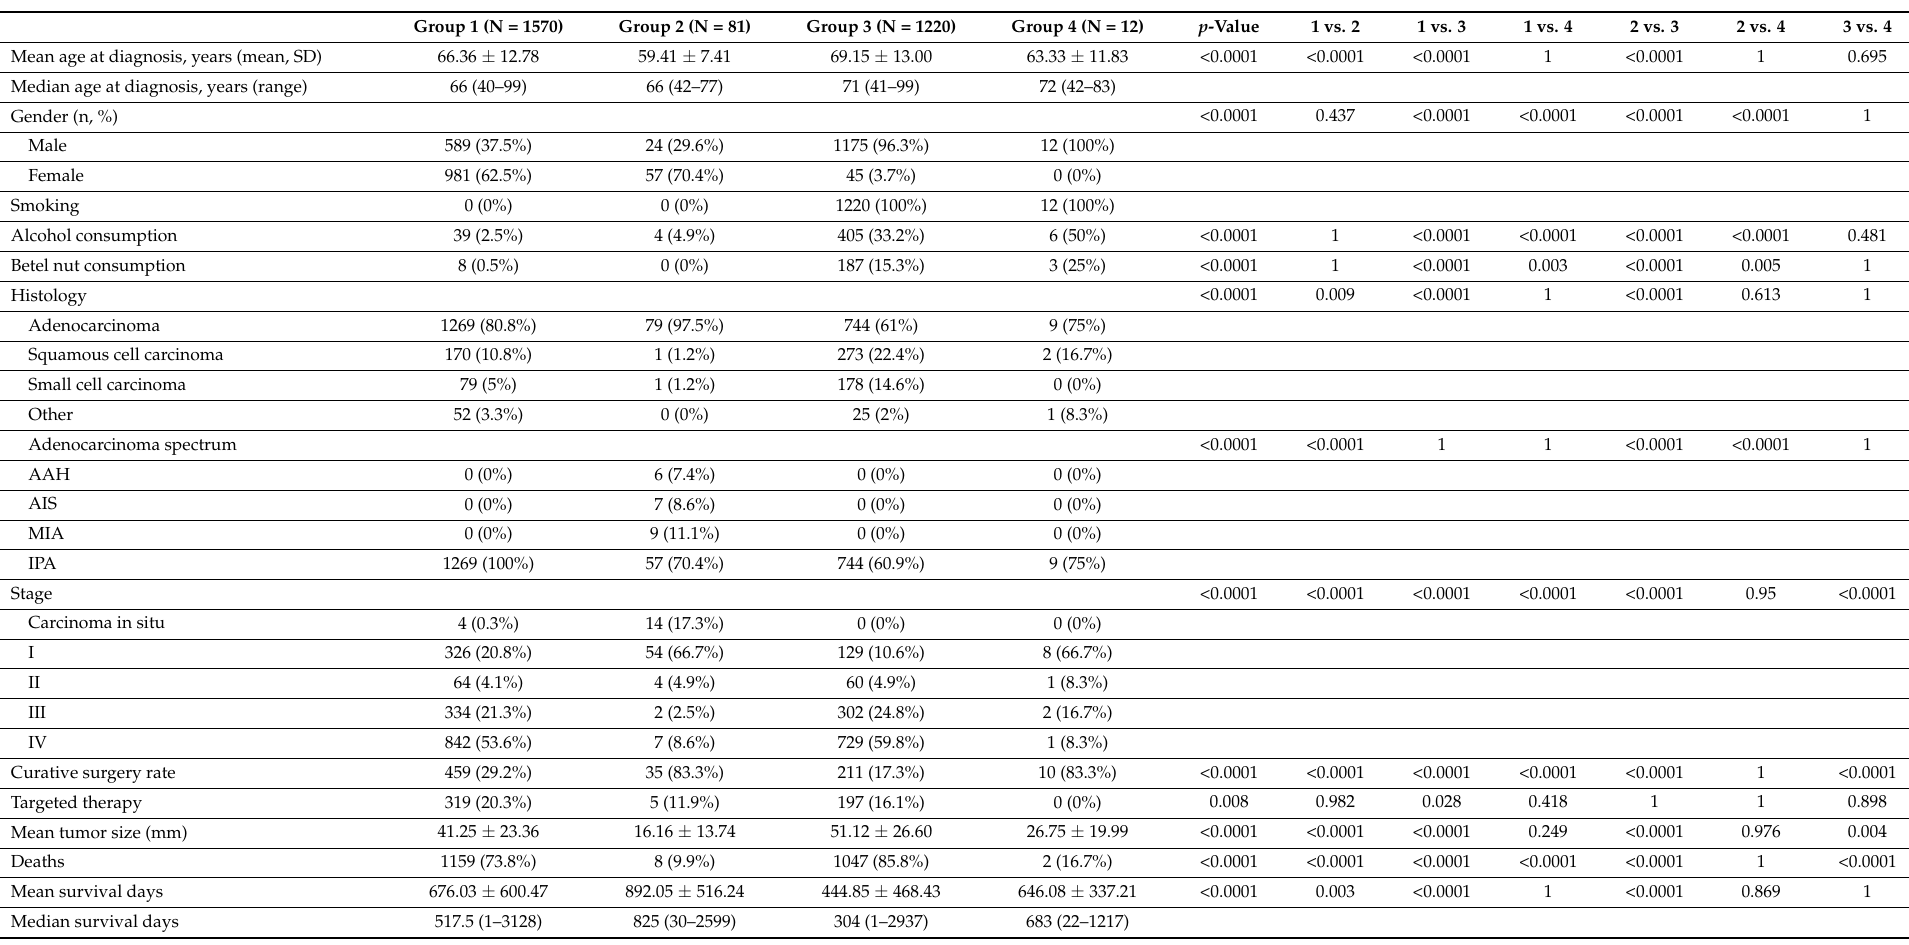
Table 1. Demographic features of enrolled subjects for group (N = 2883) comparison based on smoking and screening status (means, standard deviations, and ANOVA